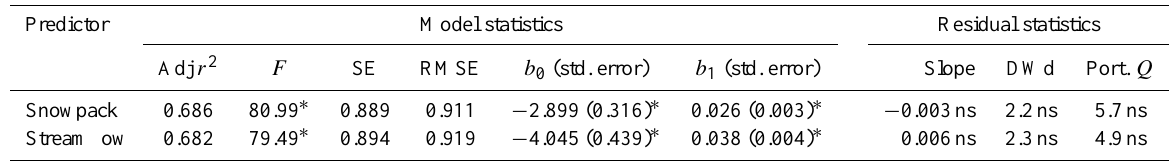
Table 4. Summary statistics for the simple linear regression models used to estimate ECH annual mass balances using regional snowpack and streamflow records.